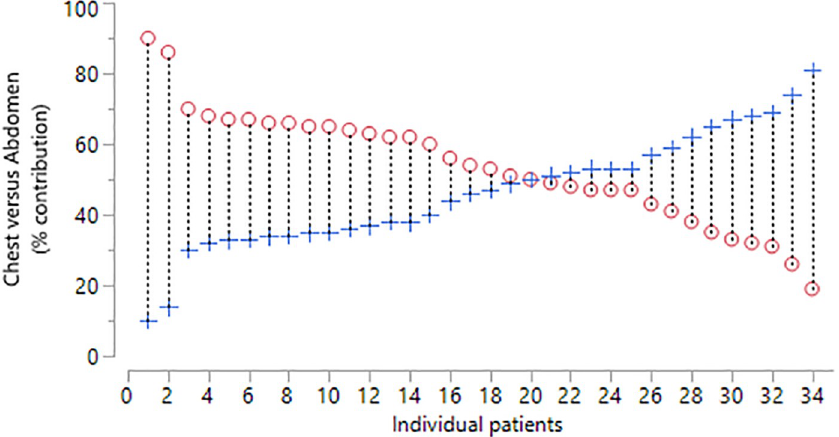
Fig 10. Percentage rib cage and abdominal wall contribution to total TA displacement for patients (n = 34) during one minute of tidal breathing. Circle (o) = rib cage contribution, Cross (+) = abdominal wall